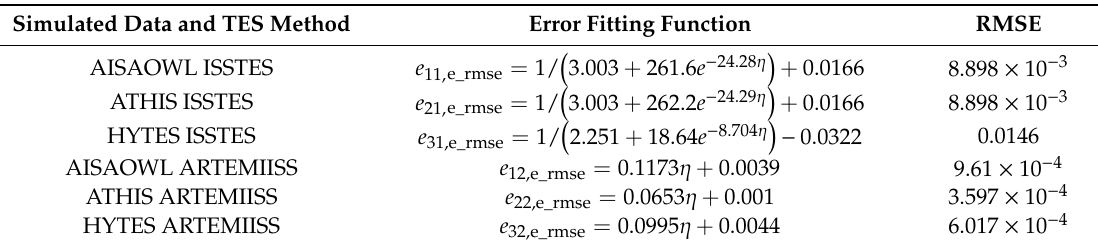
Table 12. The LSE error fitting function about NEDT when center wavelength shift ratio = 0.05 and FWHM change ratio = 0.